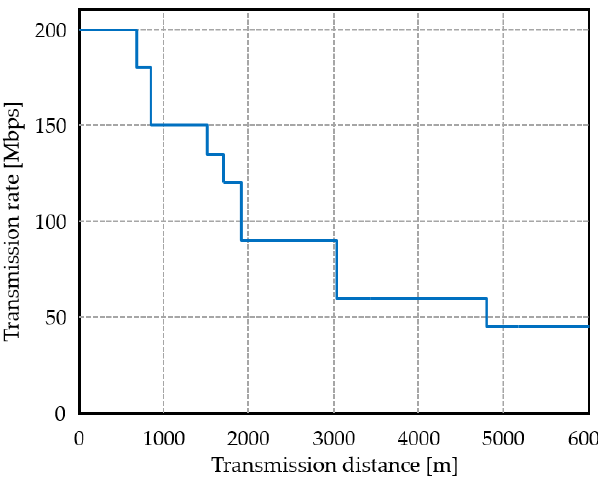
Figure 3. Transmission rate with